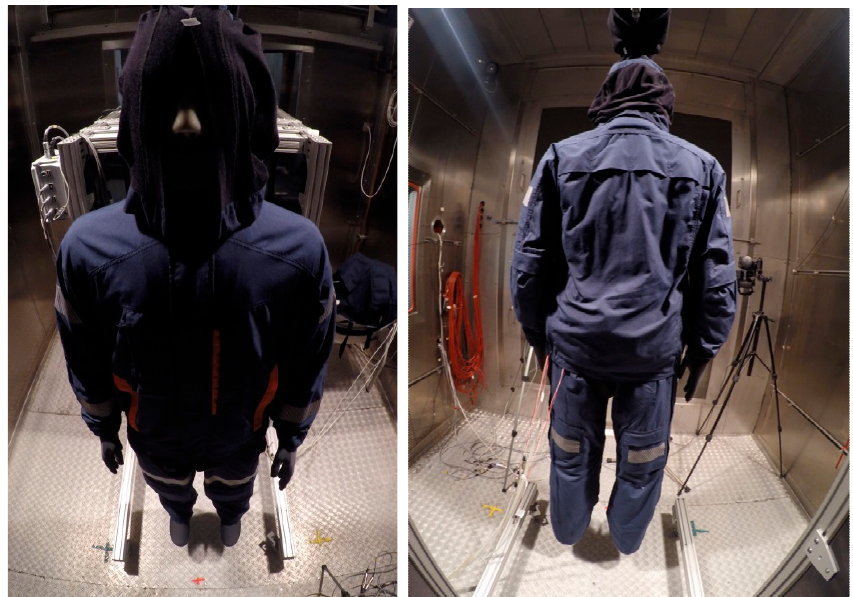
Figure 6. The manikin wearing type A undergarments with outerwear.